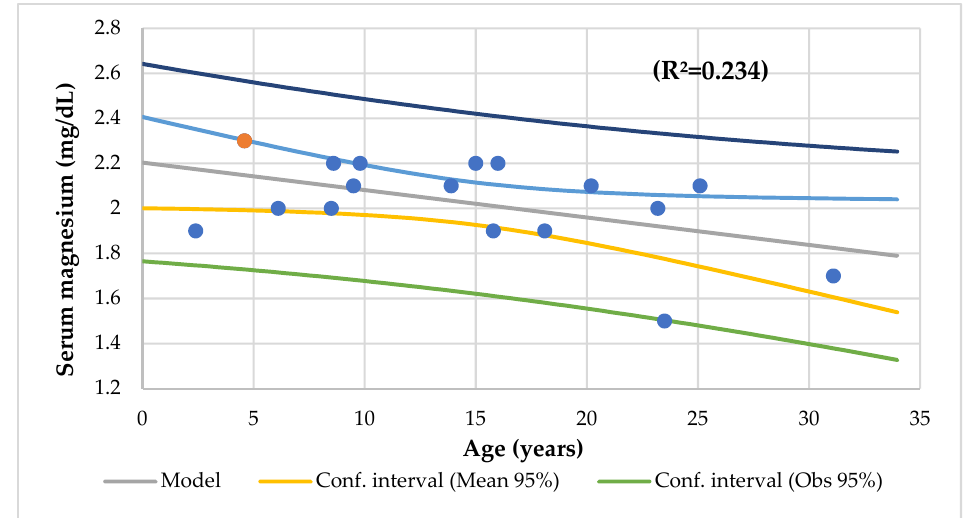
Figure 2. Regression serum magnesium (mg/dL) by age (years).